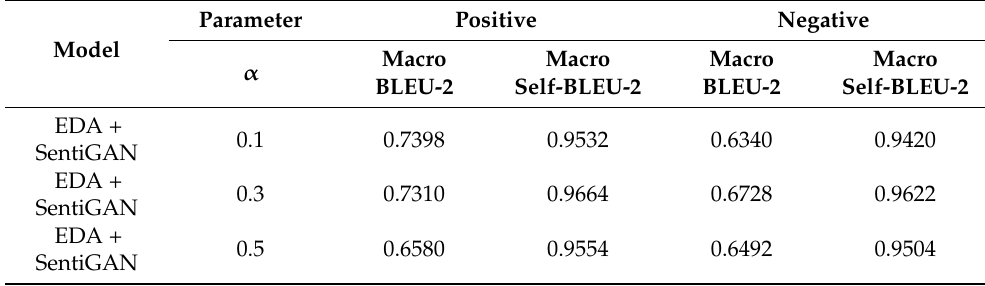
Table 2. Model tuning results on EDA hyperparameters of the GAN-based model.